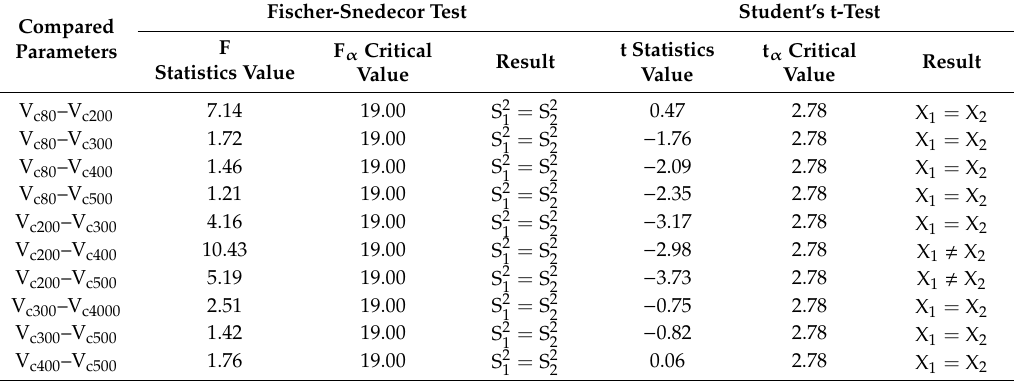
Table 6. Results of statistical analysis for V c variable during milling from aluminum layer (Al / CFRP) [28]. Compared Parameters